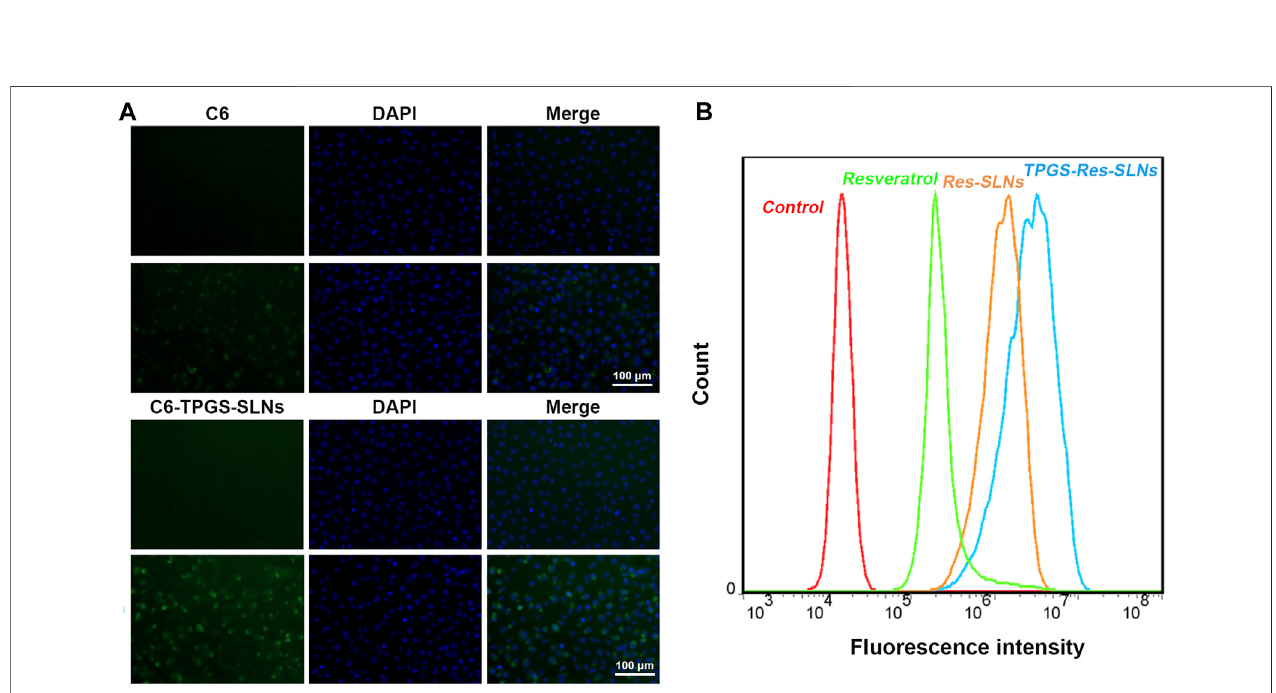
FIGURE3| Cellular uptakeand P-gpinhibition ability. (A) Confocallaser scanning microscopy (CLSM)images ofSKBR3/PRcellsafter 0.5 and 4hincubation with the coumarin-6-loaded-TPGS-SLNs (C6-TPGS-SLNs), respectively.The image was obtained from FITC channel (green), DAPI channel (blue) and the overlay of the two channels. The C6-TPGS-SLNs were green and the nucleus was stained by DAPI (blue). (B) P-gp inhibition ability of Resveratrol, Res-SLNs and TPGS-Res-SLNs increased uptake of Rho-123 in SKBR3/PR cells.